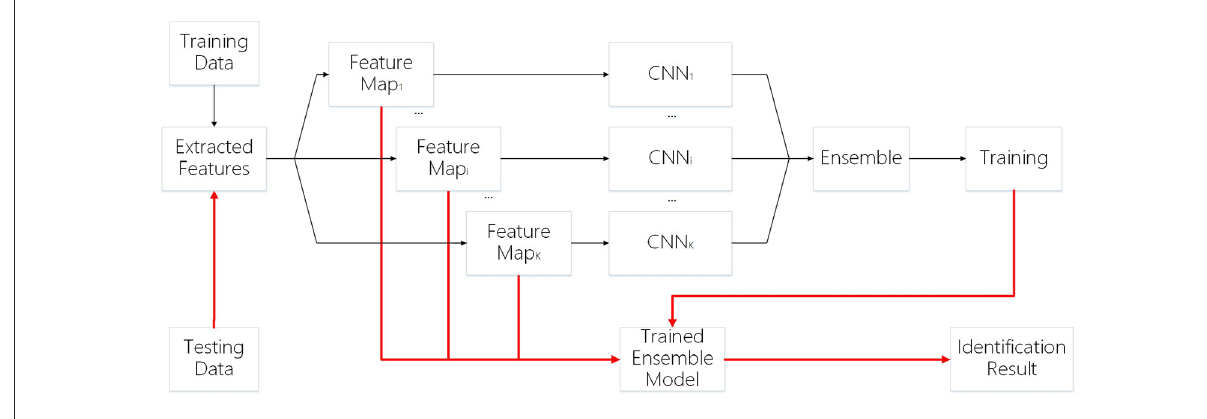
FIGURE1 Framework.